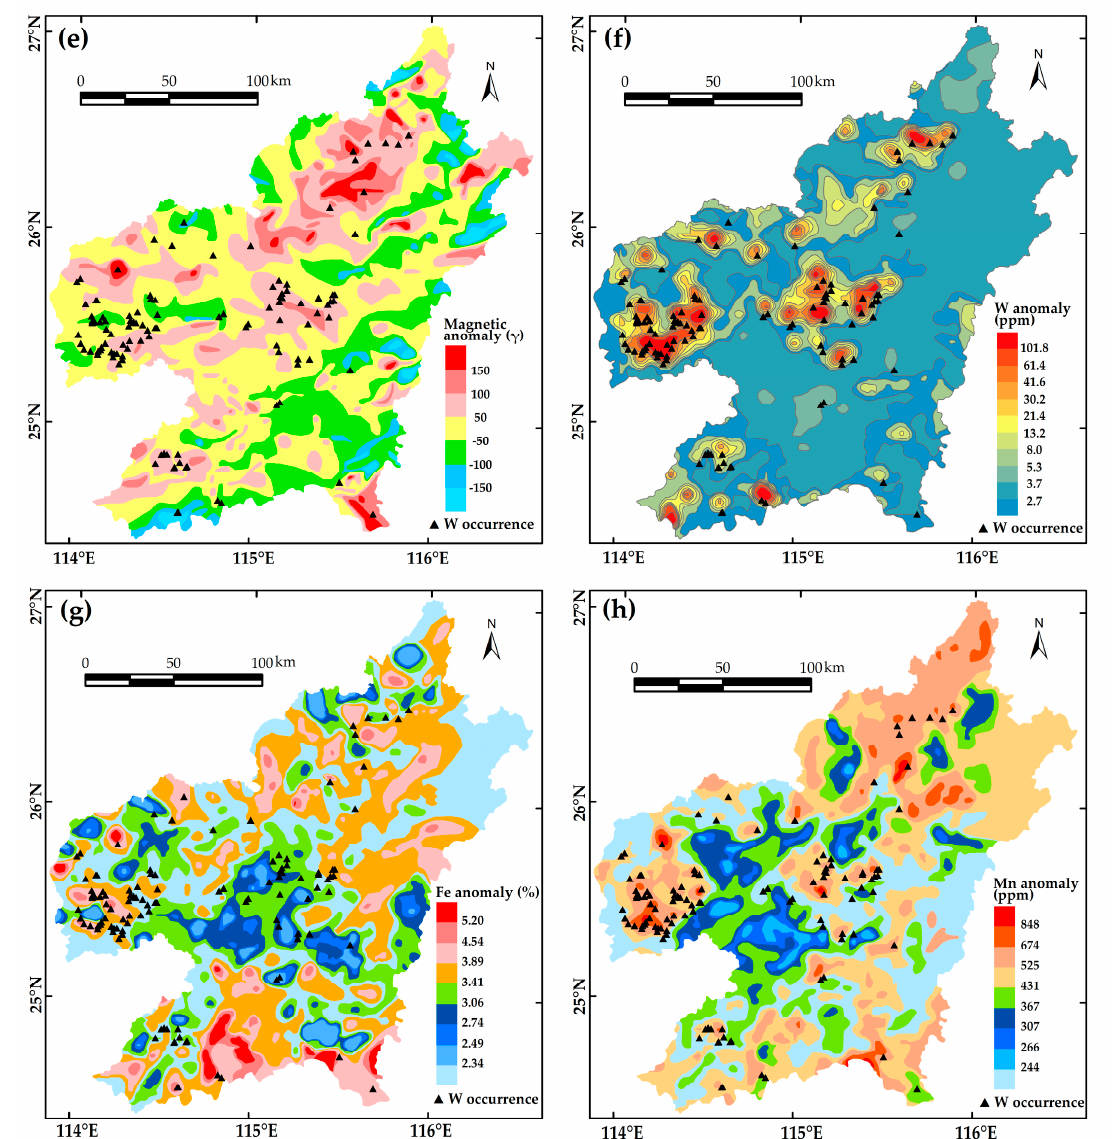
Figure 5. Evidential features used as predictor variables for prospectivity modelling: ( a ) Proximity to Yanshanian intrusions; ( b ) density of NE ‐ EW trending faults; ( c ) density of intersections of NE ‐ EW trending faults; ( d ) gravity anomaly; ( e ) magnetic anomaly; ( f ) W anomaly; ( g ) Fe anomaly; and ( h ) Mn anomaly.